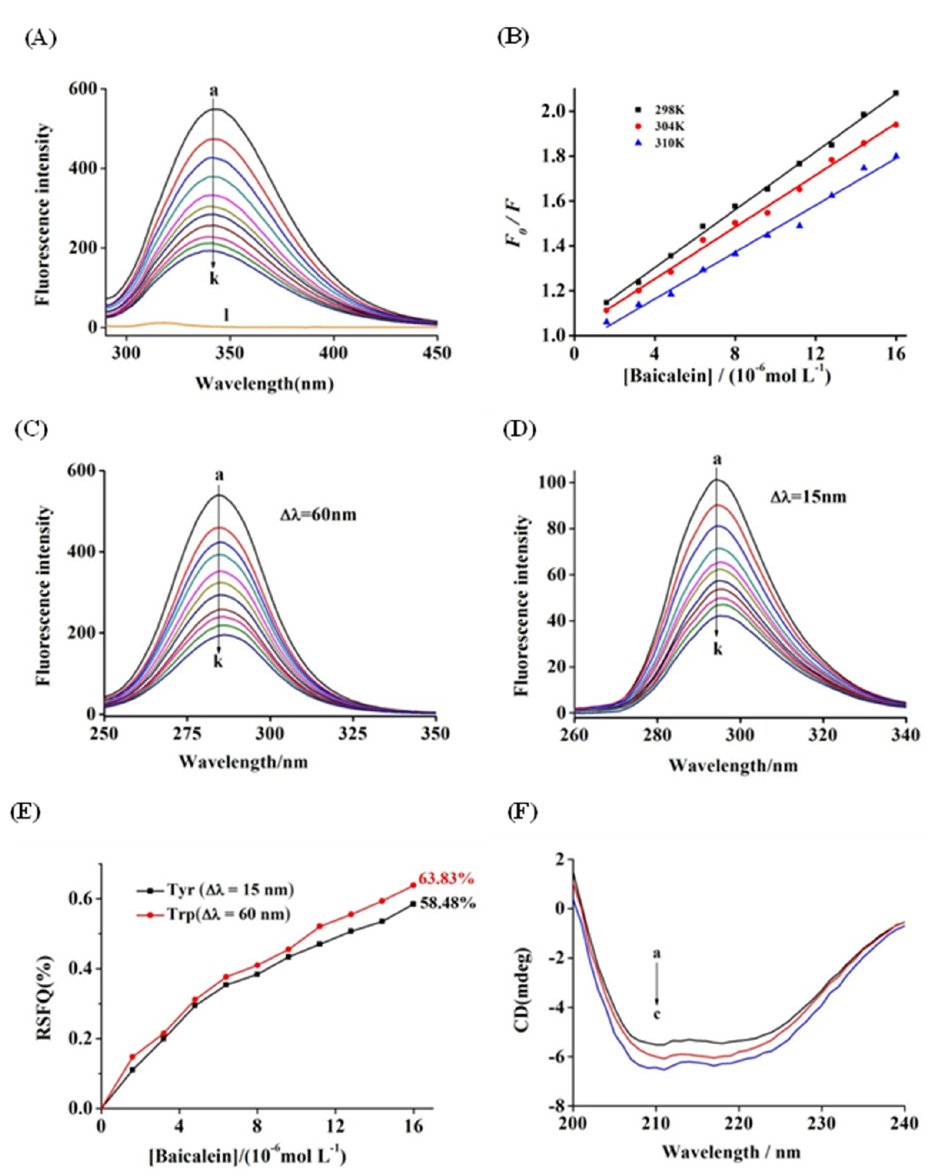
Figure 3. ( A ) Fluorescence spectra of AChE in the presence of baicalein at varying concentrations (pH 8.0, T = 25 °C ). c(AChE) = 0.17 µM, c(baicalein) = 0, 1.6, 3.2, 4.8, 6.4, 8.0, 9.6, 11.2, 12.8, 14.4, and 16.0 µM (curves a → k), respectively. Curve l depicts the emission spectrum of baicalein alone. ( B ) The fluorescence quenching curve of baicalein on AChE at 25, 31, and 37 °C. Synchronous fluorescence of AChE when baicalein was added at different concentrations: ( C ) Δλ = 15 nm, ( D ) Δλ = 60 nm; c(AChE) = 0.17 µM, c(baicalein) = 0–16.0 µM for curves a → k. ( E ) Synchronous fluorescence quenching ratio (RSFQ = 1 − F / F 0 ) of different amino acid residues of AChE. ( F ) The CD spectra of AChE in the presence of baicalein, c(AChE) = 0.75 µM; the molar ratios of baicalein to AChE were 0:1 (a), 2:1 (b), and 6:1 (c). Table 2. The quenching constants ( K SV ), binding constants ( K a ), and relative thermodynamic parame- ters for baicalein − AChE interaction under three temperature